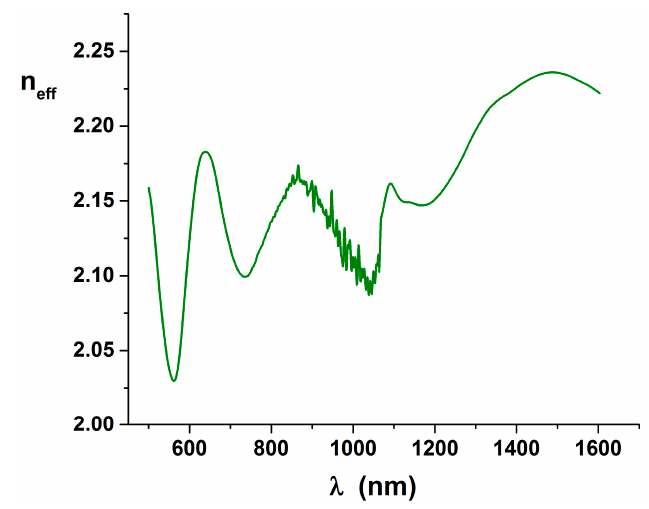
Figure 7. Plot of the n eff curve, derived from the set visible in Figure 5 and correspondent to the previously shown reflectance curve.